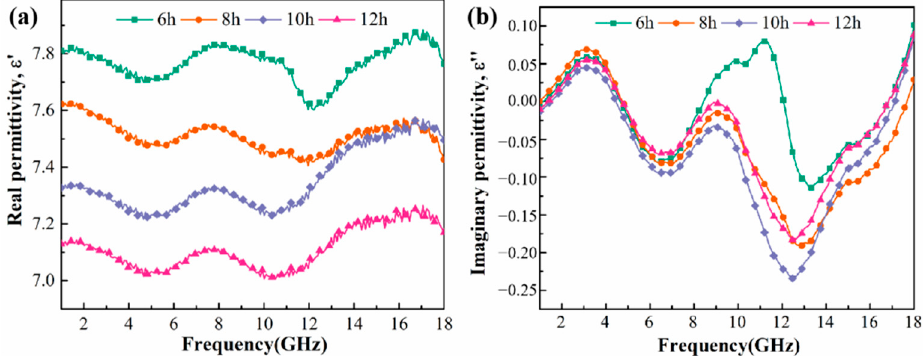
Figure 4. Particle size of Fe 73.2 Si 16.2 B 6.6 Nb 3 Cu 1 nanocrystalline alloy powder: ( a ) particle size distribution; ( b ) change in average particle size as a function of milling time.